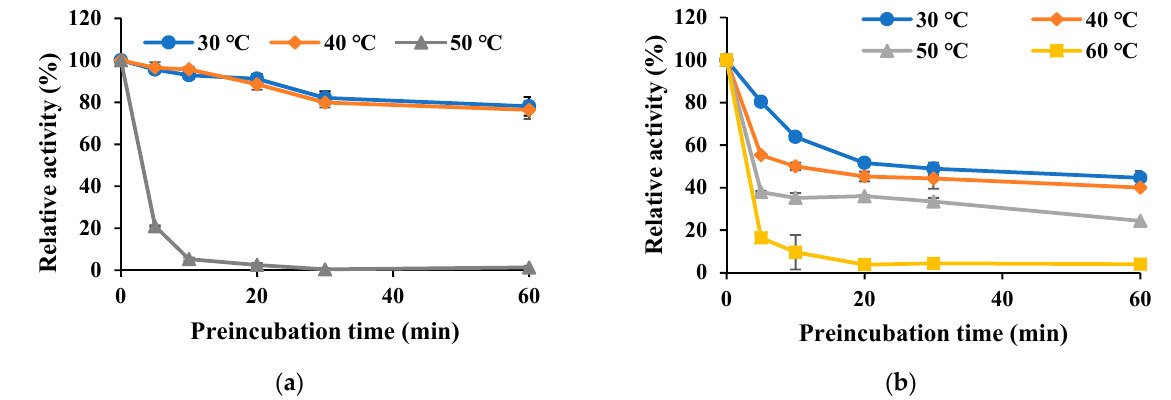
Figure 6. Thermal stabilities of Est8L ( a ) and Est13L ( b ). The enzyme was preincubated at the designated temperatures for the indicated times prior to activity measurements.